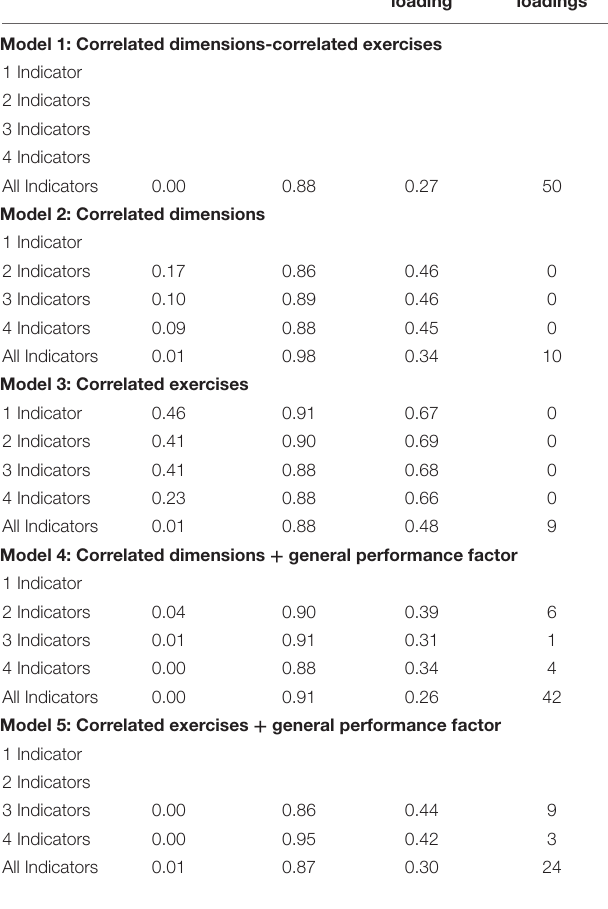
TABLE 3 | Summary of model parameters across models for combinations of single indicators. Model